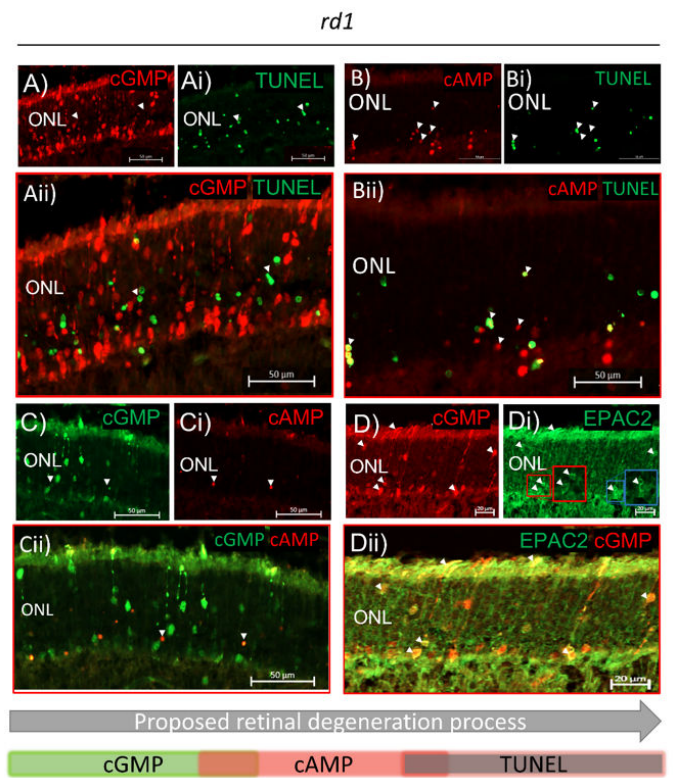
Figure 3. cGMP, cAMP, and EPAC2 are associated with cell death. All pictures represent the rd1 retina at PN11. A to D all show: X, first staining; Xi, second staining; Xii, merged stainings; and increased magnification. ( A – Aii ) Accumulated cGMP did not overlap with TUNEL + cells in the rd1 retina. Arrowheads in A and Ai indicates that there was no obvious overlap between the cGMP and TUNEL + cells. ( B – Bii ) Accumulated cAMP overlapped with TUNEL + cells in some cases. Arrows in Bii indicate such an overlap (yellow). ( C – Cii ) cGMP and cAMP showed overlap in a few photoreceptor nuclei*. A to C suggest that high intracellular cGMP is followed by cAMP accumulation, which in turn is followed by TUNEL positivity (a proposed order of events is indicated in the bottom panel). ( D – Dii ) Accumulated cGMP colocalized with EPAC2 in degenerating cells, where EPAC2 appeared to have higher expression. Arrowheads point to colocalization of accumulated cGMP and high EPAC2 expression. The red and blue inserted squares in Di show cells containing augmented EPAC2 expression (small, red, and blue) and magnifications of these (large, red, and blue). Micrographs are representative of three biological replicates. ONL: outer nuclear layer. As judged by the position and appearance of the stained